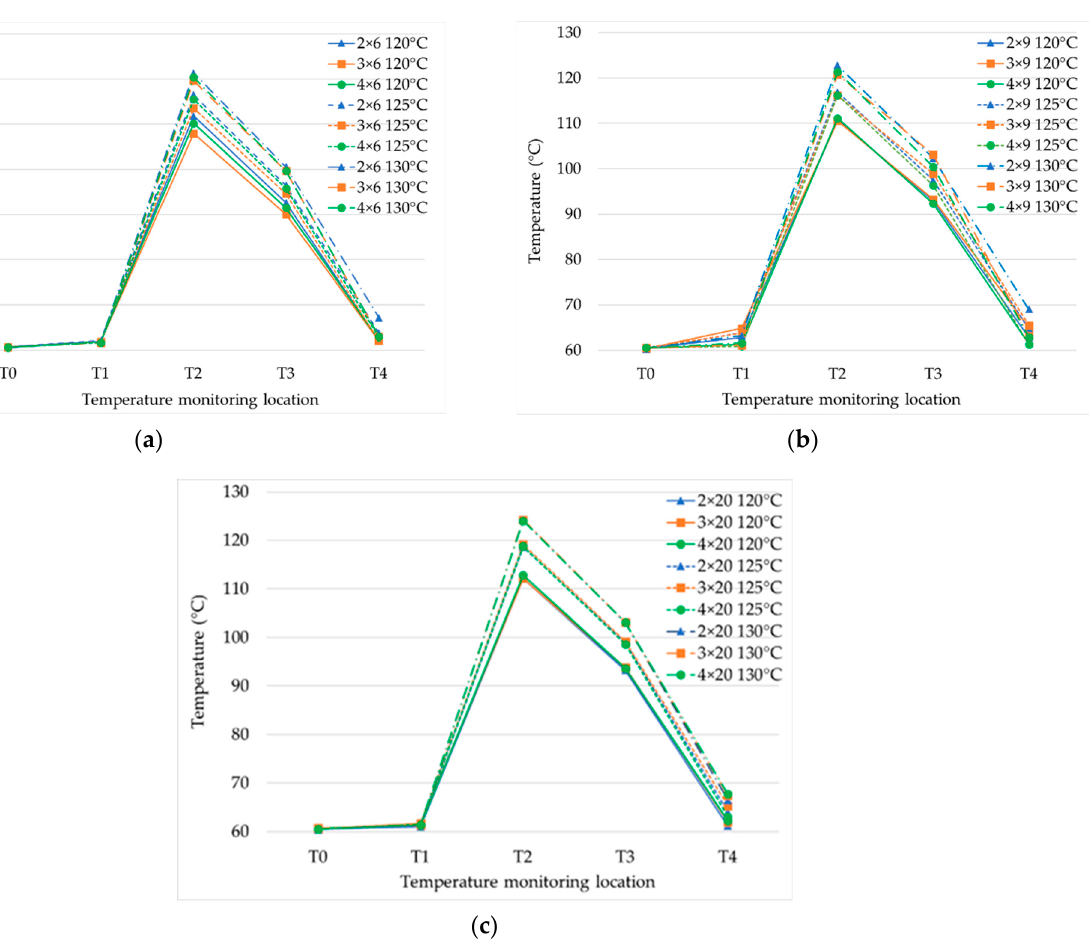
Figure 5. Product temperatures with various impingement configurations of jet nozzle numbers of water (2, 3, 4) and 6 steam nozzles ( a ), 9 steam nozzles ( b ), and 20 steam nozzles ( c ) at H / d = 5, with steam temperature at 120 °C, 125 °C, and 130 °C.